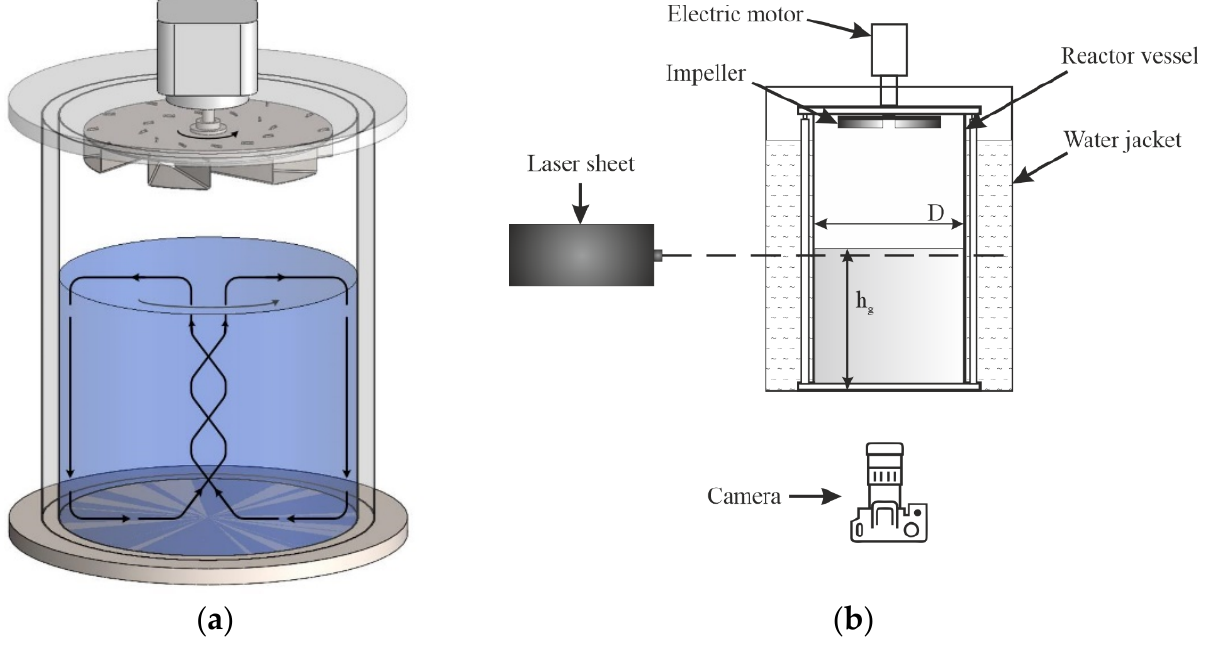
Figure 2. The experimental setup: ( a ) organization of vortex motion and ( b ) setup diagram.